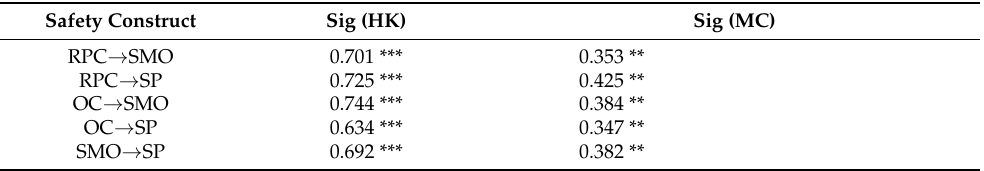
Figure 5. Structural equation modeling of SP in Mainland China.